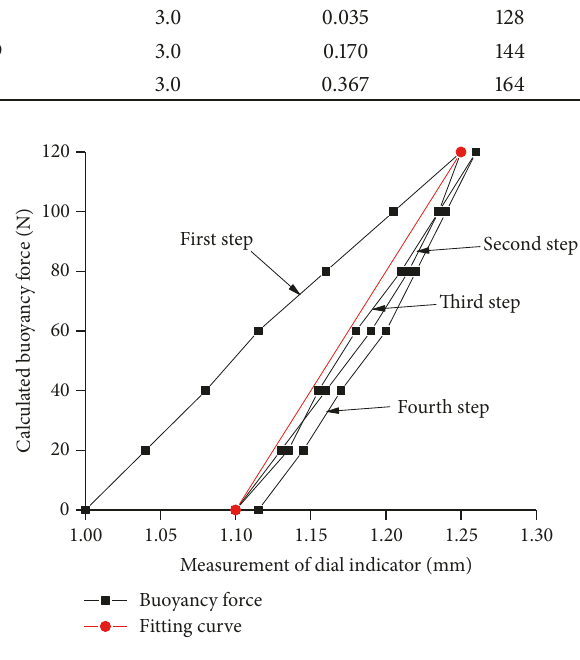
Table 3: Measured and theoretical pore pressures and buoyancy forces acting on the structure placed on homogeneous soil layer. Hydraulic Test case gradient